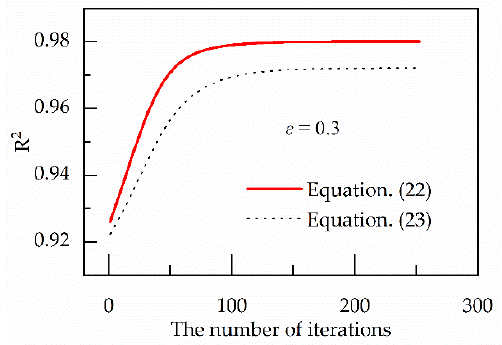
Figure 6. Variation of R 2 of Equations (22) and (23) with iterations.